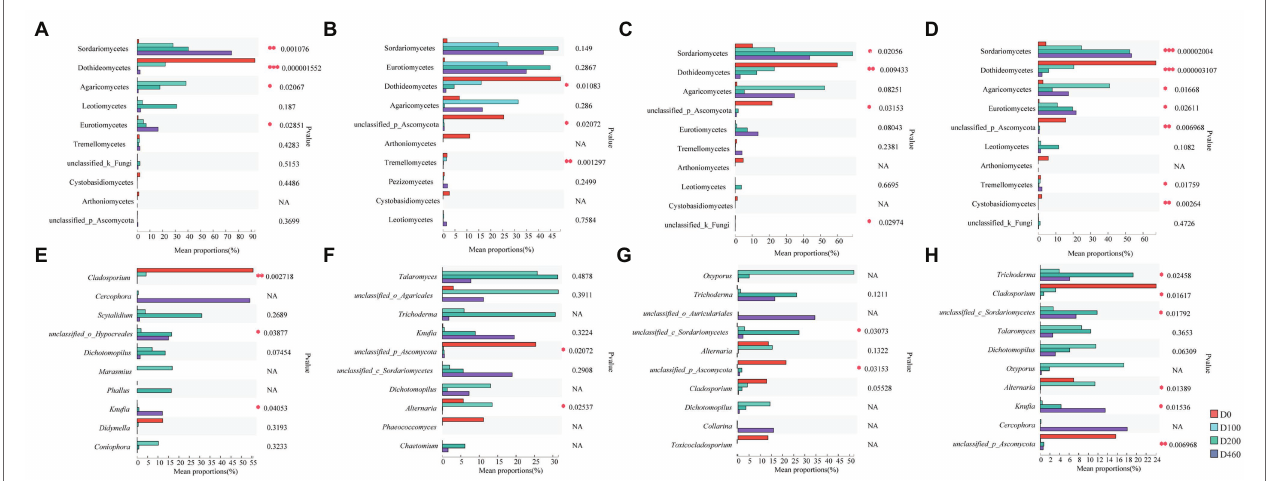
FIGURE 4 | Difference of dominant fungi classes (A-D) and genera (E-H) at four litter decomposition stages in S516 (A , E) , S536 (B , F) , S560 (C , G) , and the whole copper mining area (D , H) . Significance levels were denoted with ** p < 0.01 and *** p <